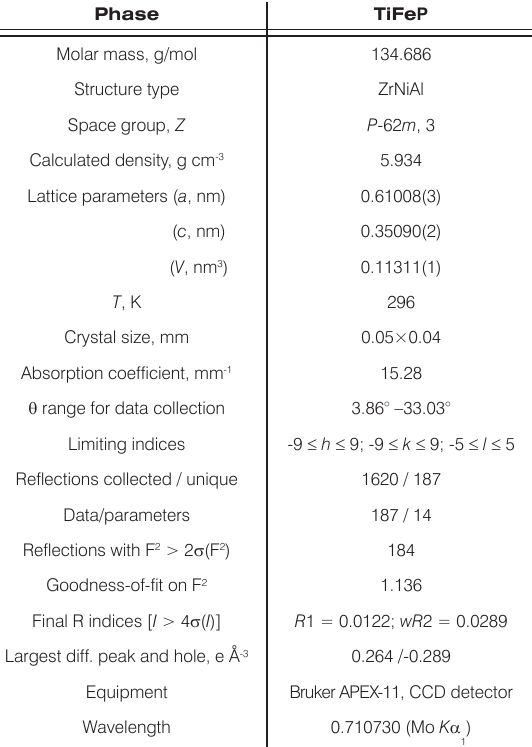
Table 3. Crystal data and structure refinement parameters for the TiFe Р